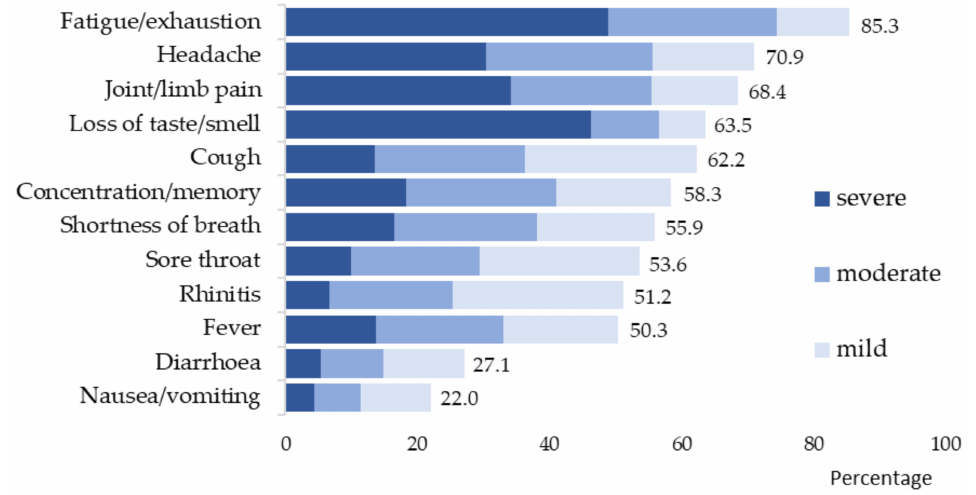
Figure 2. Acute symptoms of COVID-19 in the mild, moderate and severe degrees of severity (n =